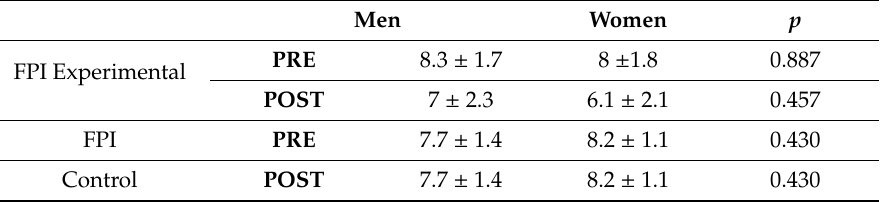
Table 2. Di ff erences by gender in both groups.